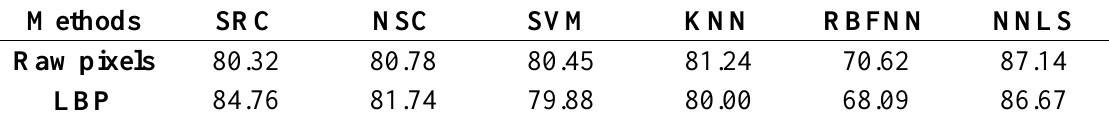
Table 3. Recognition accuracy (%) of various used methods when using the raw pixels and the LBP features.